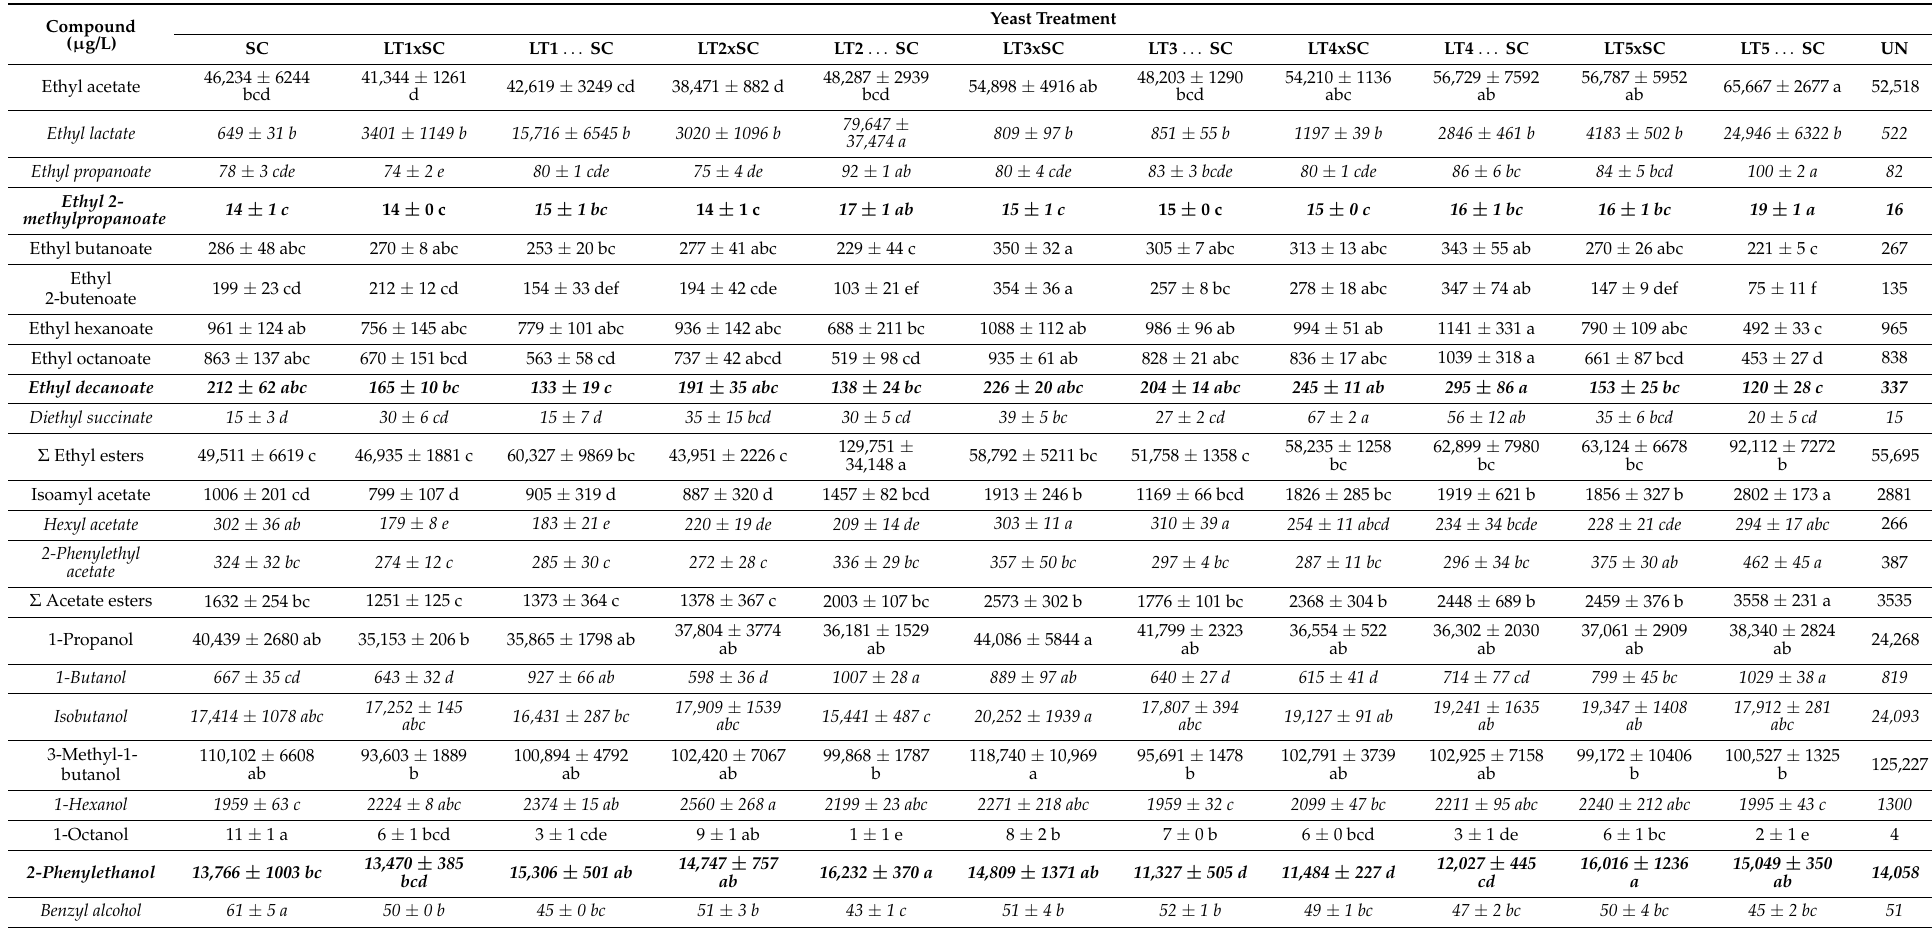
Table 2. Volatile composition of Viognier wines fermented with 12 yeast treatments. Volatile compounds in italics were detected below their sensory threshold in all wines. Compounds in italics and bold were in some wines below, and in others above, their sensory threshold (Table S2). Values ( µ g/L) are the mean of winemaking triplicates with standard errors, and different letters within the same row represent significant differences (ANOVA; Tukey’s post-hoc α = 5%). The yeast treatments include the Saccharomyces cerevisiae monoculture (SC), five Lachancea thermotolerans strains (LT1-LT5) in co-inoculations (xSC) or sequential inoculations ( . . . SC) with S. cerevisiae , and an un-inoculated treatment (UN). The un-replicated treatment UN was excluded from the statistical